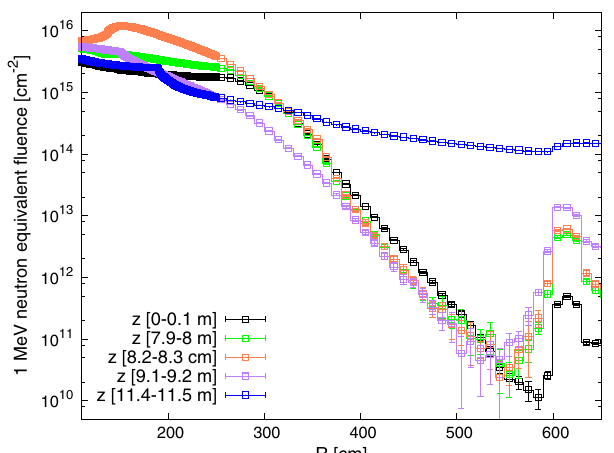
FIG. 11. 1 MeV neutron equivalent fluence after an integrated luminosity of 30 ab − 1 as a function of the distance from the beam line, at different z positions in the calorimeters: at the detector center (black), at the end of the barrel (green), at the EMCAL endcap (orange), at the IP face HADCAL endcap (violet), and at the non-IP face of the HADCAL (blue). The values are averaged on the Φ angle.